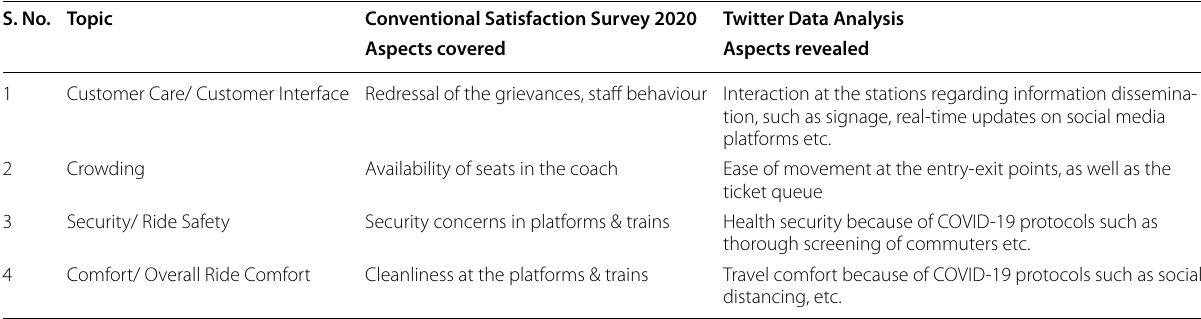
Table 3 Comparison between the aspects in the Conventional Satisfaction Survey 2020 and Twitter